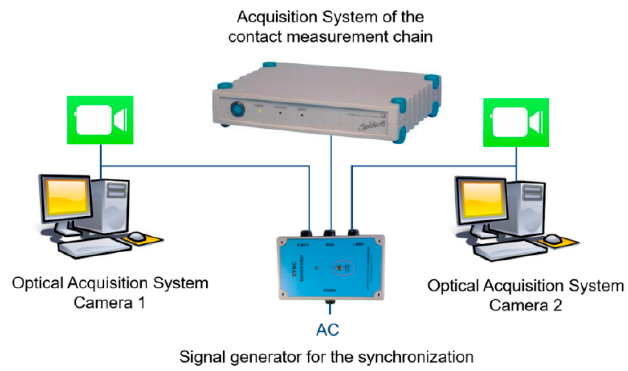
Figure 9. Synchronization of image acquisition and contact measurements.